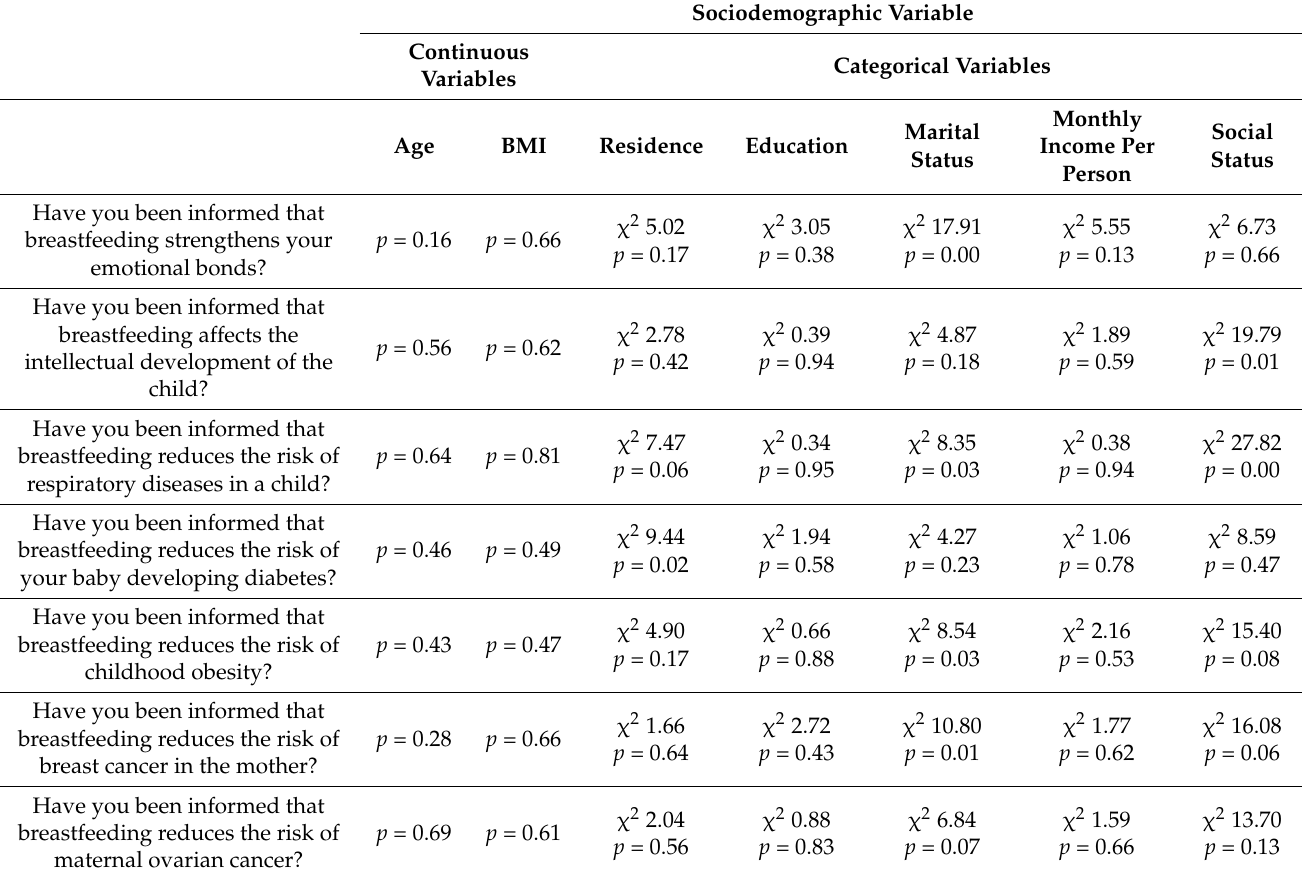
Table 7. Breastfeeding knowledge levels in relation to sociodemographic